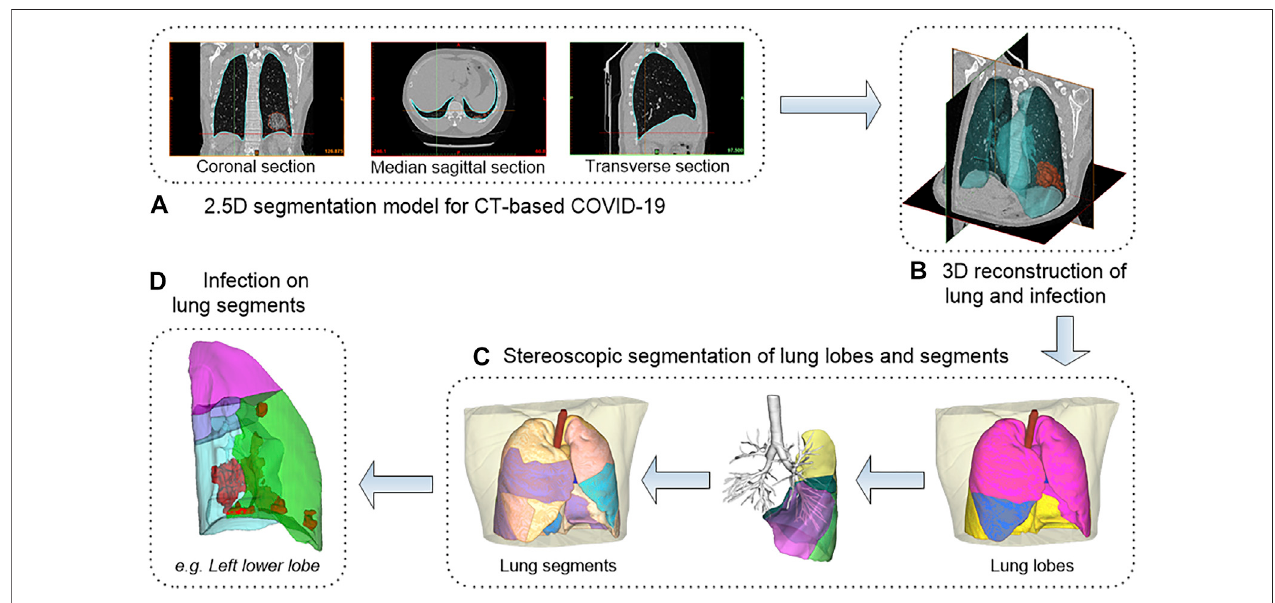
FIGURE 4 | The work fl ow of 3D reconstruction and stereoscopic segmentation of chest CT. (A) shows 2.5D segmentation model for CT-based COVID-19. (B) shows 3D reconstruction of lung and infection. (C) shows stereoscopic segmentation of lung lobes and segments. (D) shows infection on lung